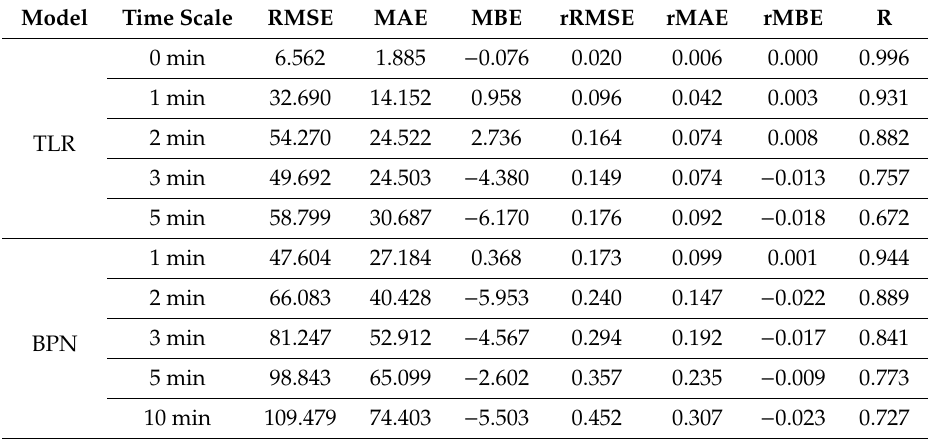
Table 3. Forecasting error comparison between the linear regression model and the neural network model on 8 November